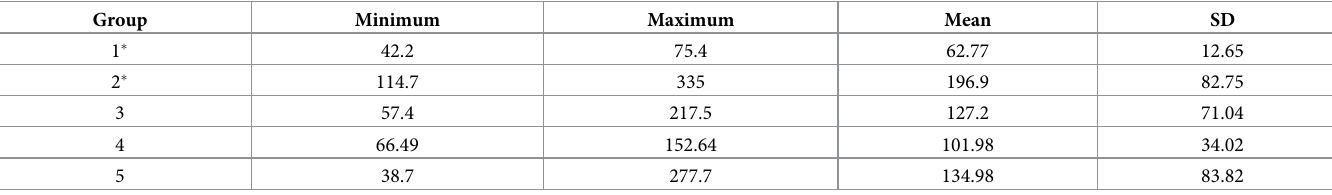
Table 1. Mean, stand deviation (SD), and range of debonding force values (N).